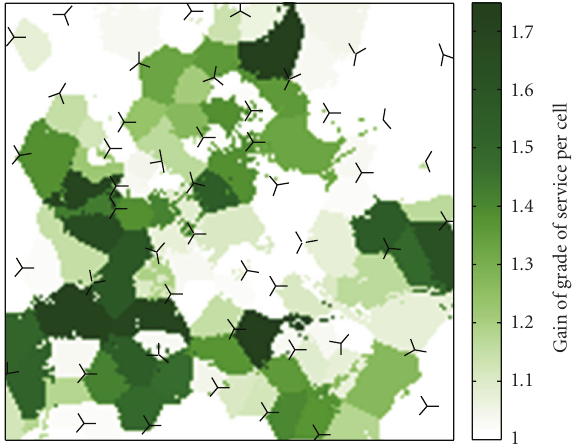
Figure 7: Gain of grade of service for unloading the UMTS cells by δ = δ ( B ) .